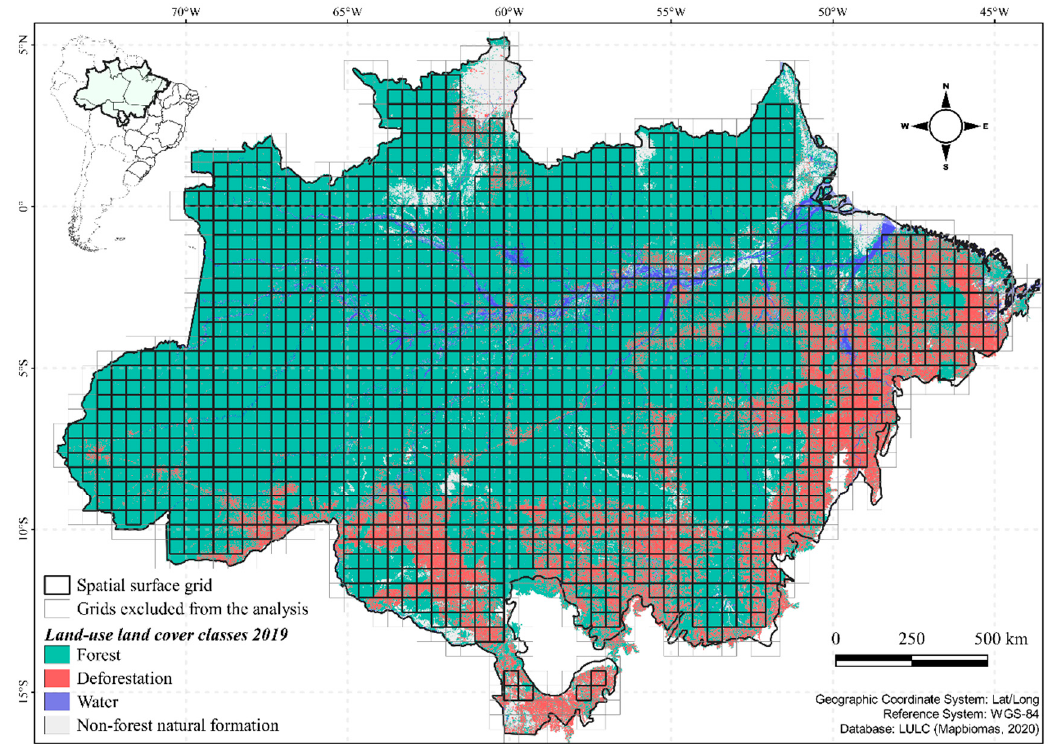
Figure 1. Location of the base spatial surface grids used in our analysis.